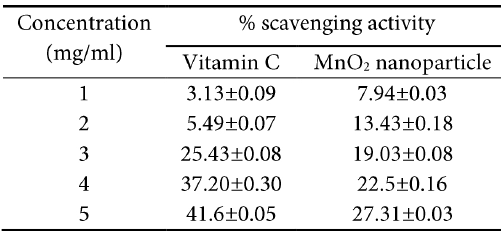
Table 1 . Free radical scavenging activity of